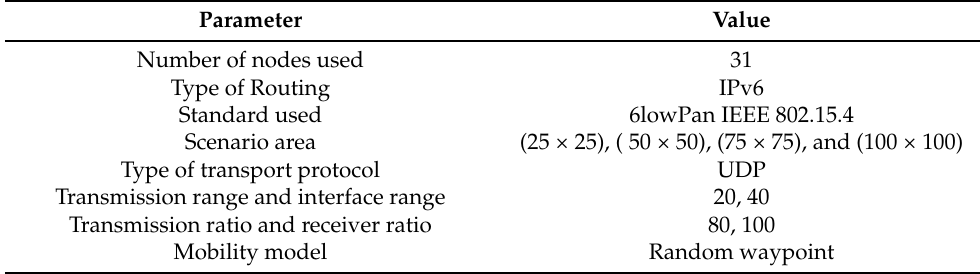
Table 3. Sensors Platforms and Simulation Settings.